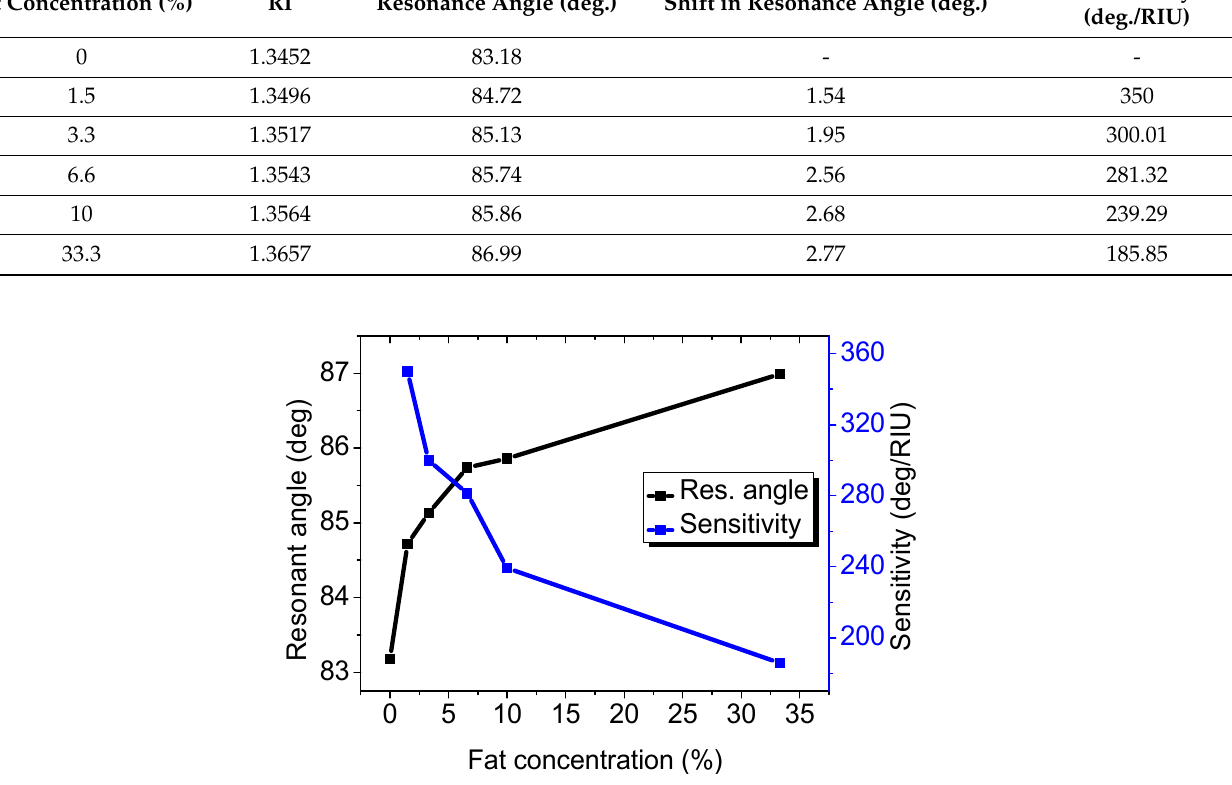
Figure 5. Resonance angle and sensitivity versus the fat concentration.